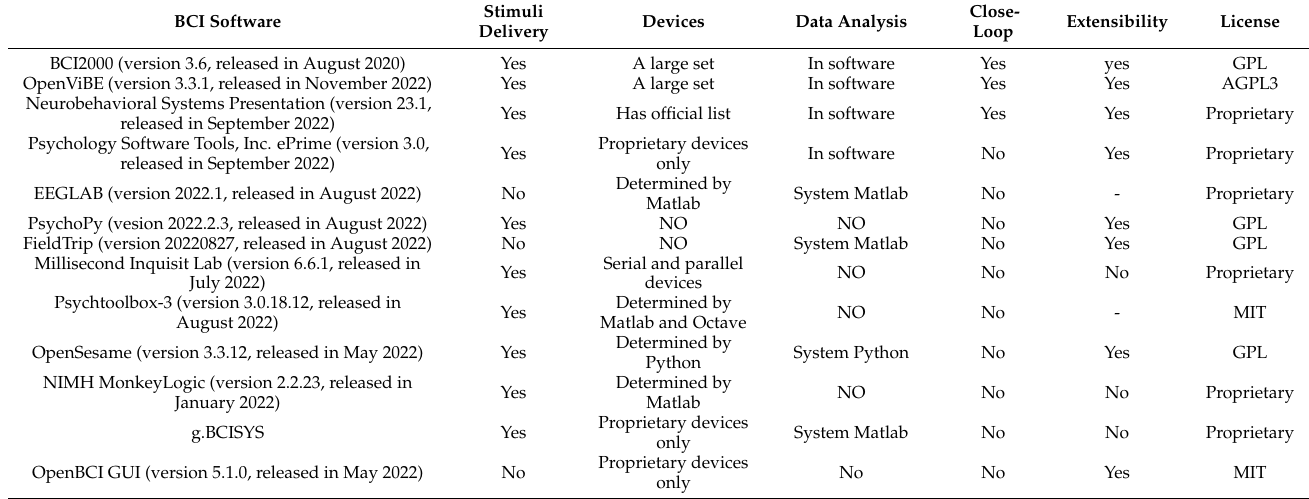
Table 2. BCI software. The most widely used software comprises free licenses: GNU General Public License (GPL), GNU Affero General Public License-version 3 (AGPL3), or MIT License (MIT). Usually, open-source tools admit extensibility by third-party